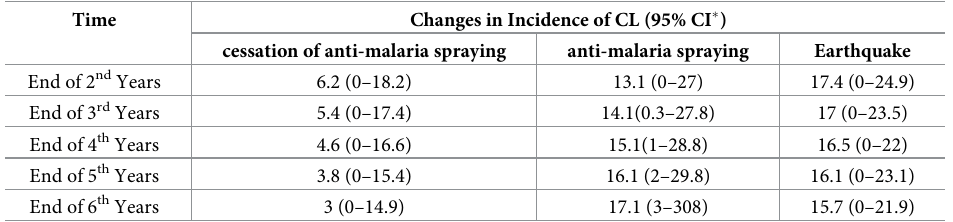
Table 4. Changes in cutaneous leishmaniasis (CL) incidence per 1,000 after three major events in Bam, southeast- ern Iran